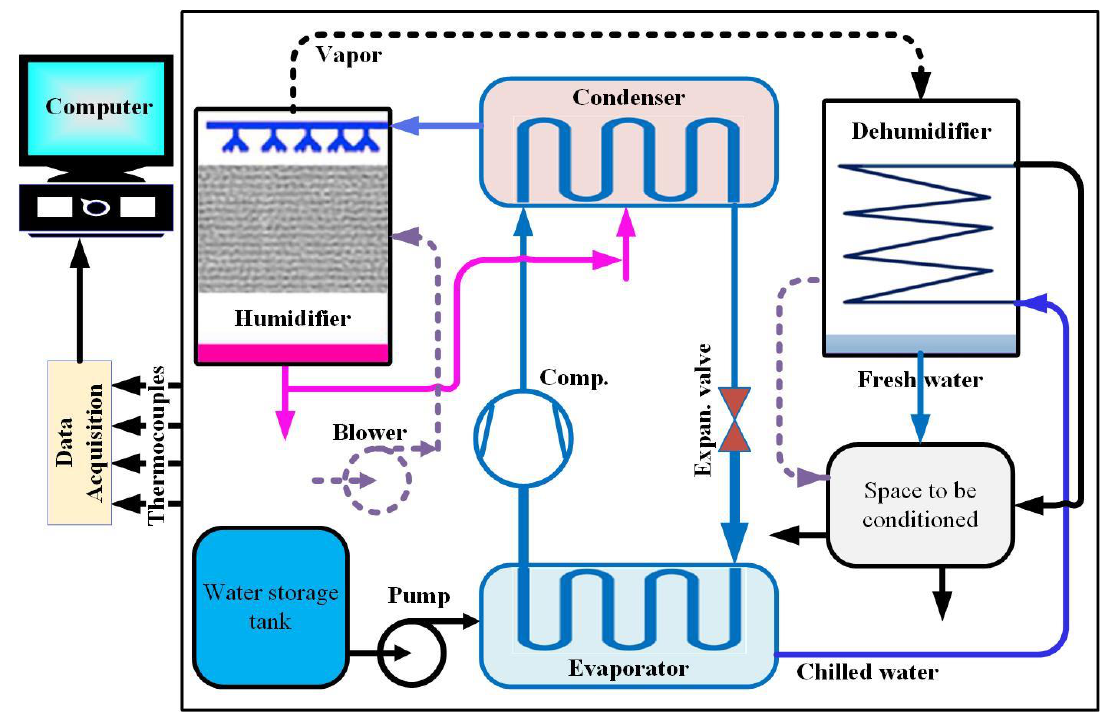
Figure 11. Schematic diagram of experimental HDH-HP (adapted from [111]).